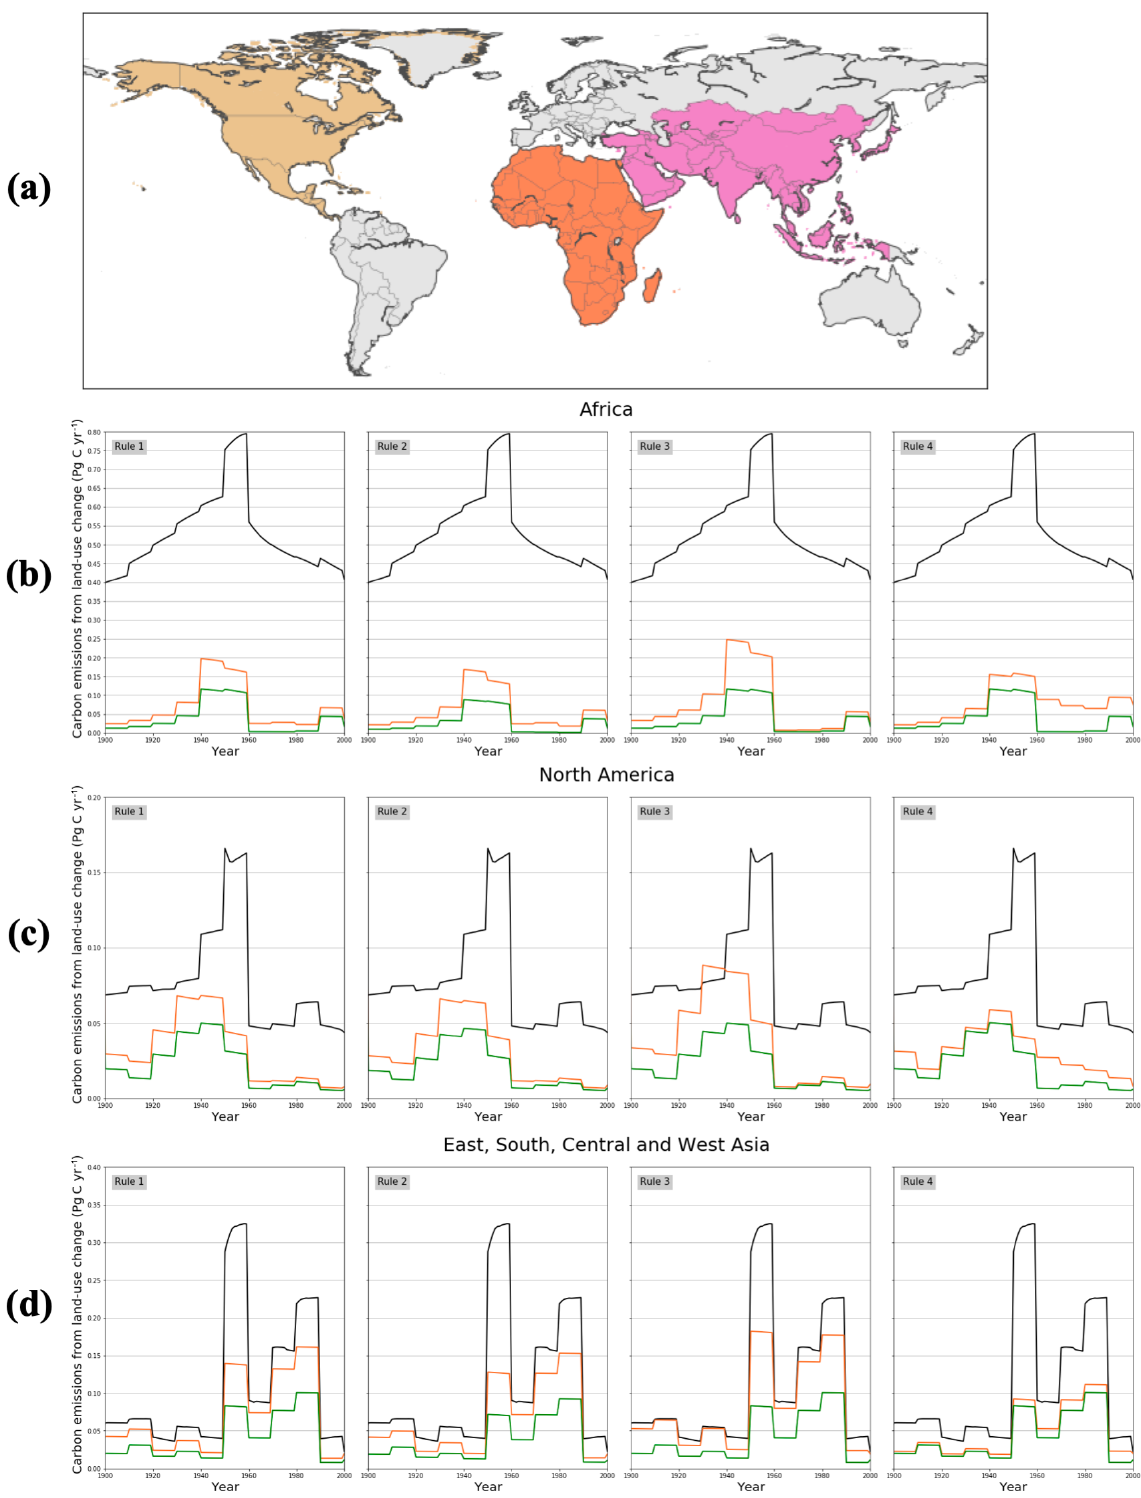
Figure 6. As in Fig. 5 but three regions: (b) Africa; (c) North America; and (d) East, South, Central, and West Asia. Panel (a) illustrates the defined boundaries of (b) – (d)